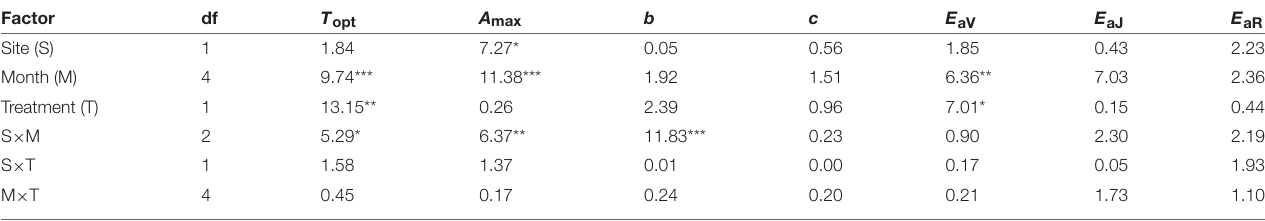
TABLE 3 | Summary of three-way ANOVA without replication for the effects of latitude, month, warming treatment and their interactions on leaf characteristics. Factor df